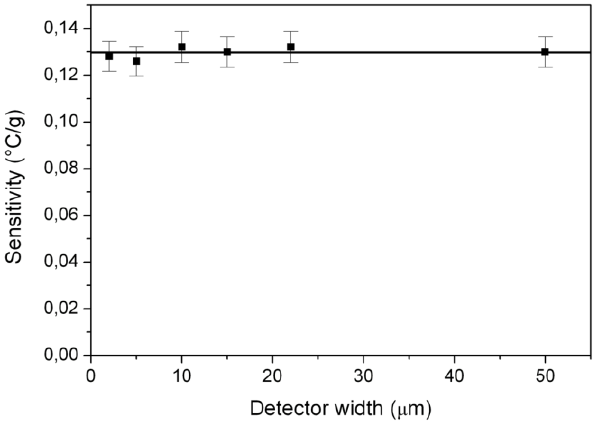
Figure 6. Experimental thermal sensitivity vs. detector